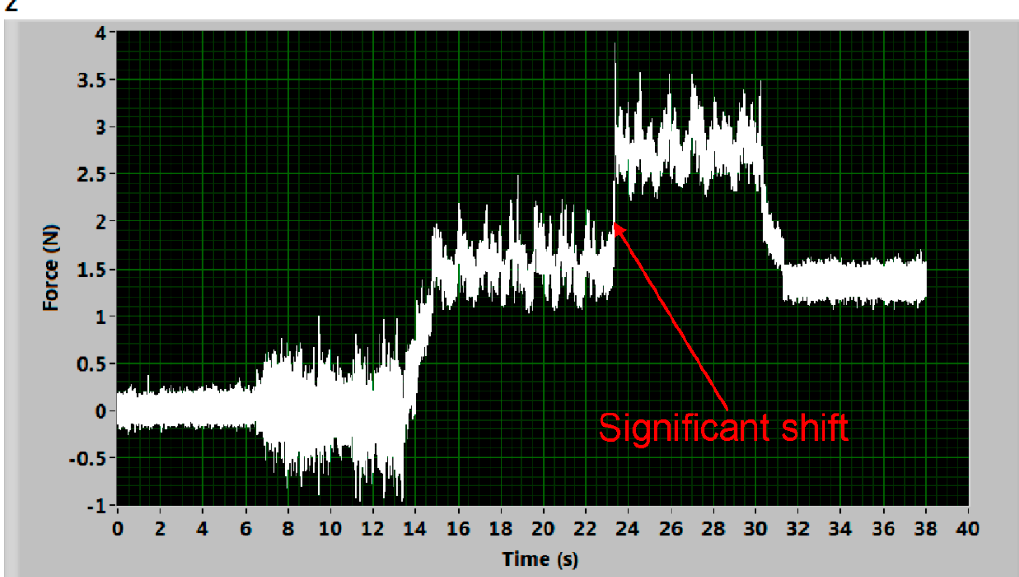
Figure 5. Deformation force signal with a significant shift during the stable part of cutting (sample of steel 1.4541, traverse speed 100 mm/min).